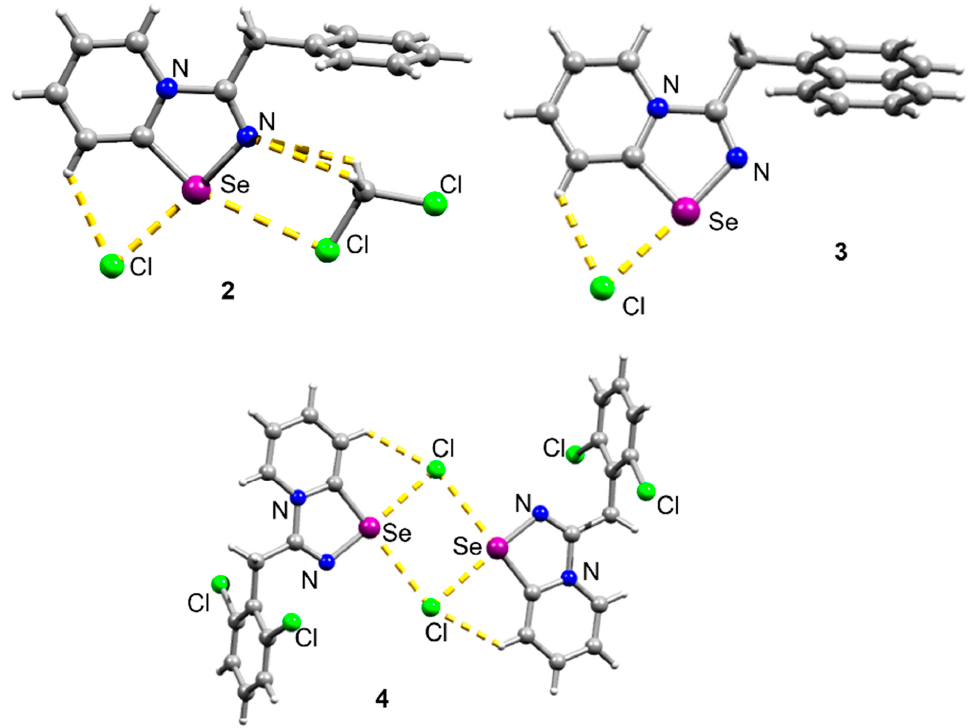
Figure 1. Ball-and-stick representations of crystal structures of 2 – 4 . Grey and light-grey spheres represent carbon and hydrogen, respectively.